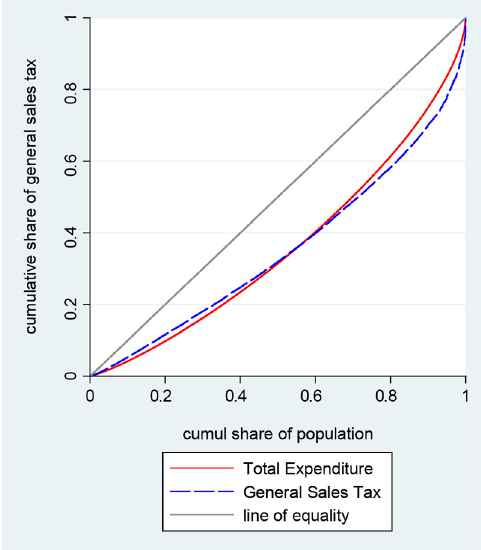
Figure 7. Concentration